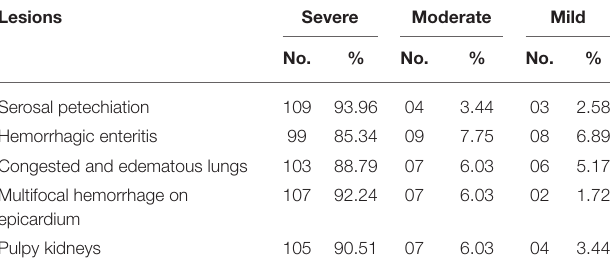
TABLE 2 | Morbidity, mortality, and case fatality of goats caused by enterotoxemia. Farm